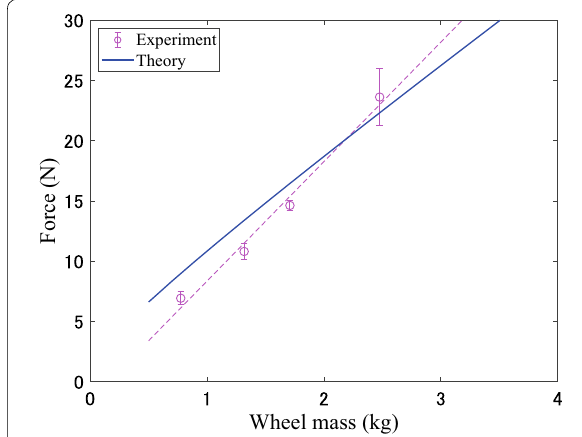
SD resistance force of steady-state sinkage at Fig. 15 Mean ± different wheel mass. Diameter 0.17 m; width 0.04 m